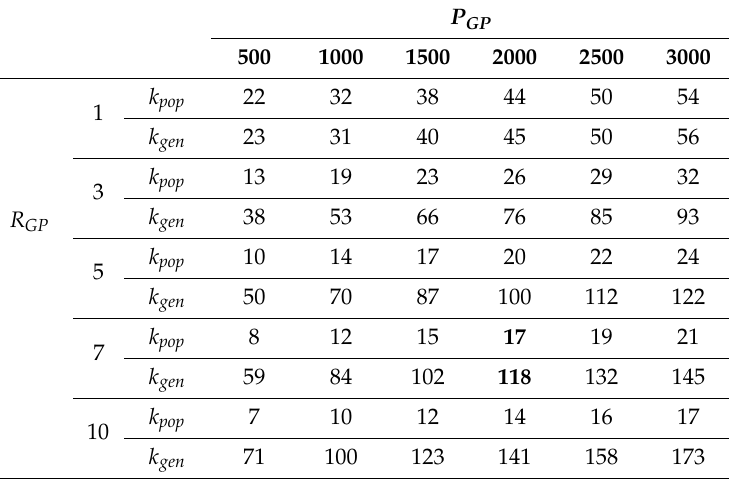
Table 7. Design of experiments for the two variables P GP and R GP . The optimal number of generation k gen and population size k pop are in